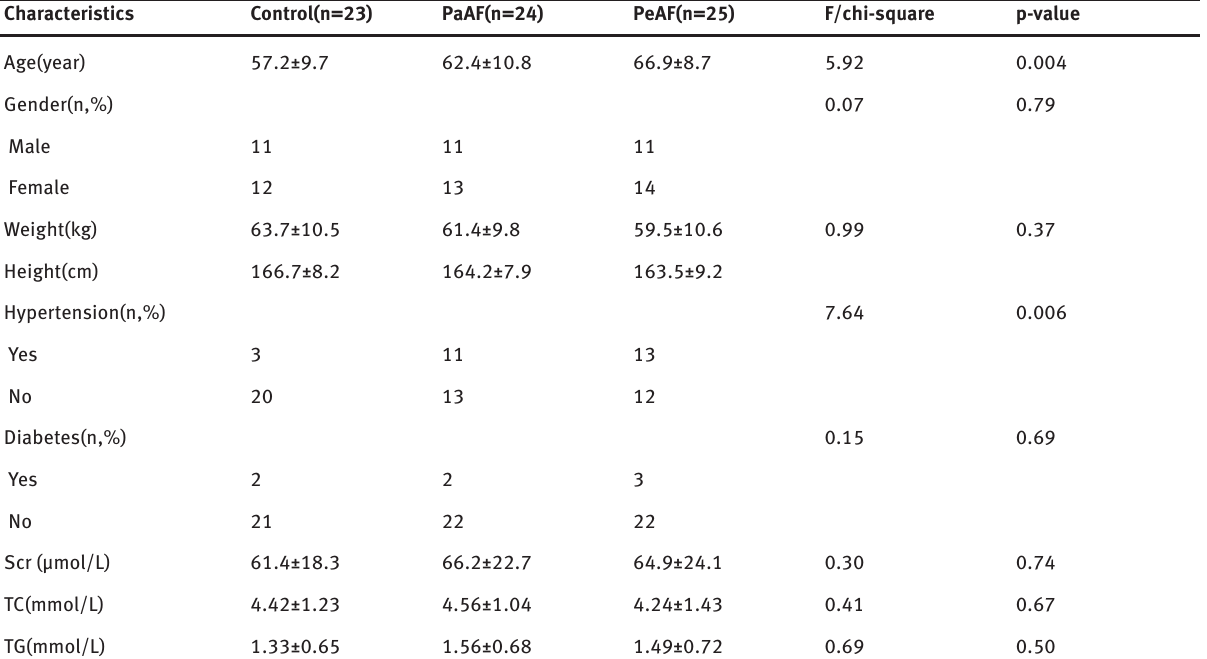
Table 1: The main characteristics of the included subjects. Characteristics